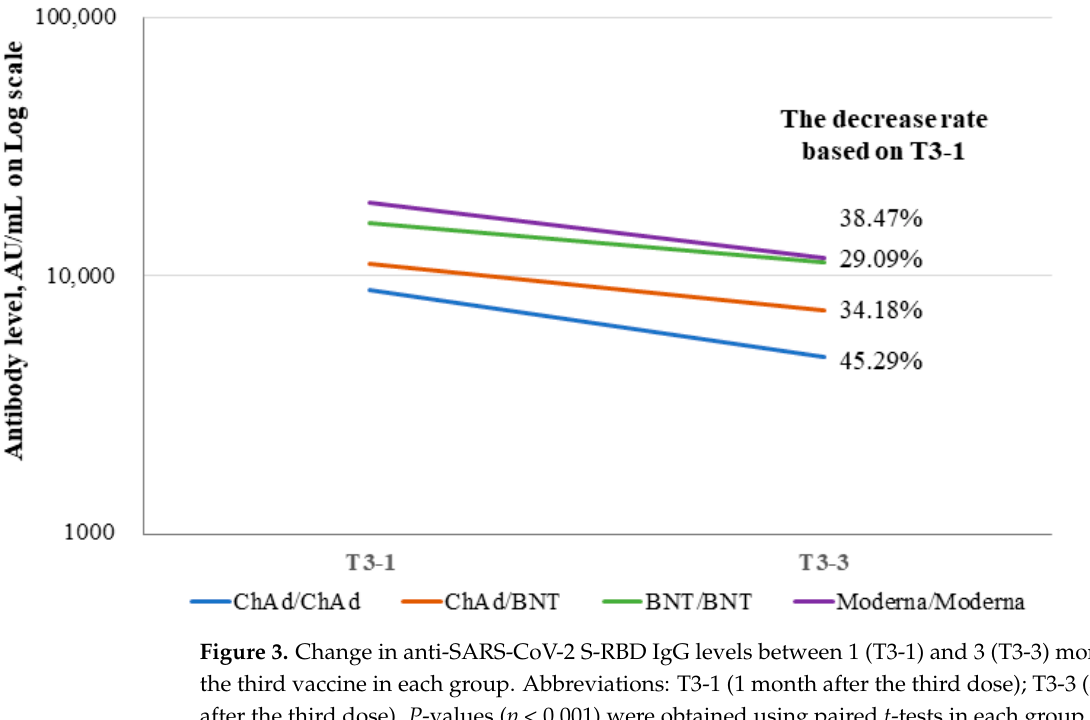
Figure 2. Anti-SARS-CoV-2 S-RBD IgG levels at T3-1 by vaccination type ( p < 0.001). * p -values ( p < 0.01) were calculated by a post-hoc analysis using Scheffe’s test: ChAd/ChAd, ChAd/BNT < BNT/BNT, and Moderna/Moderna.